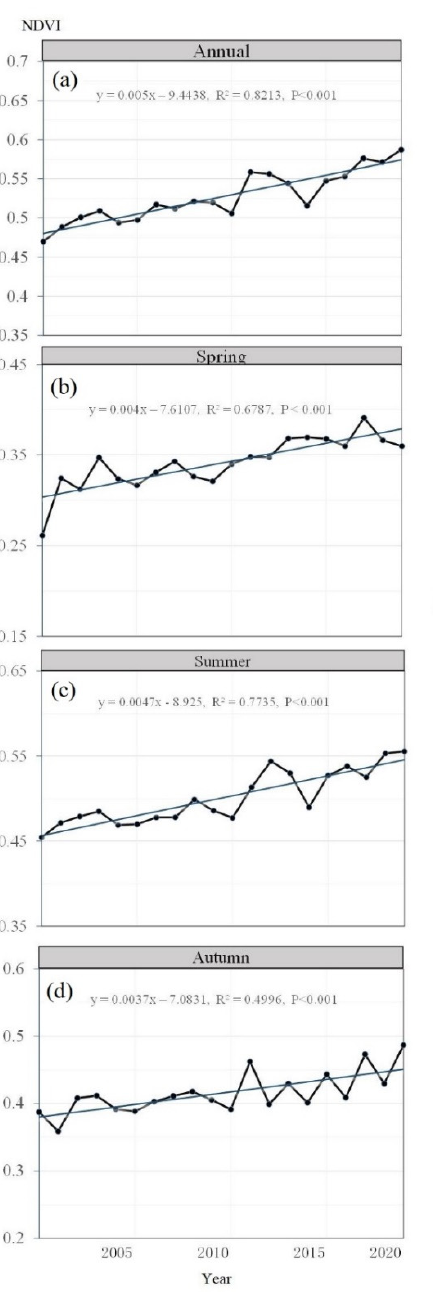
Figure 6. The temporal variation trend of NDVI and SIF in YRB from 2001 to 2020 ( a – h ). ( a ) Annual NDVI; ( b ) Spring NDVI; ( c ) Summer NDVI; ( d ) Autumn NDVI; ( e ) Annual SIF; ( f ) Spring SIF; ( g ) Summer SIF; ( h ) Autumn SIF.